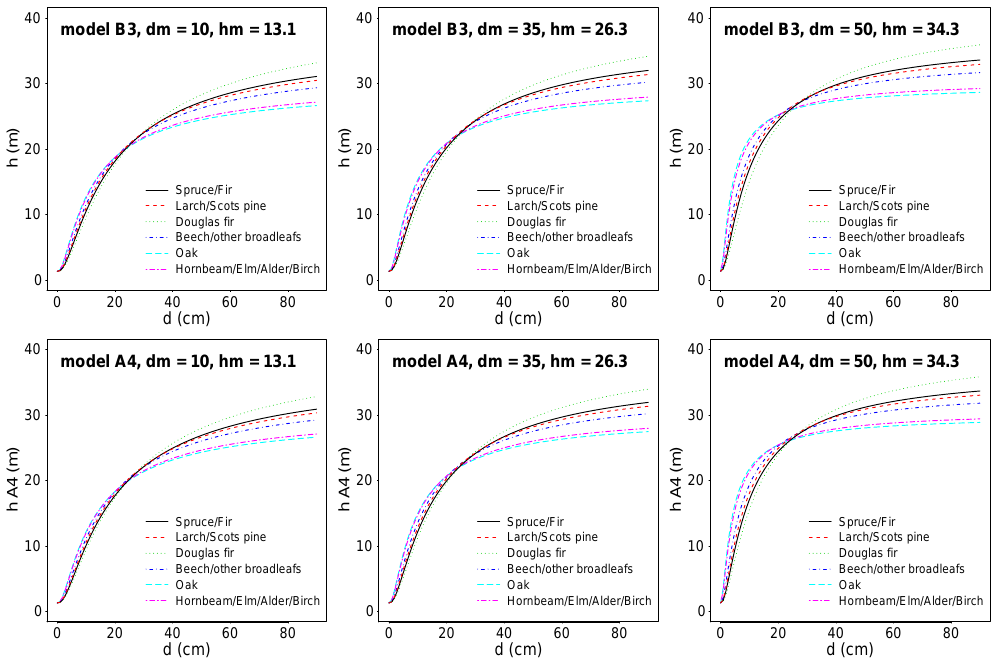
Figure 4. Mean curves separately for each tree species group (Model B3 and Model A4).